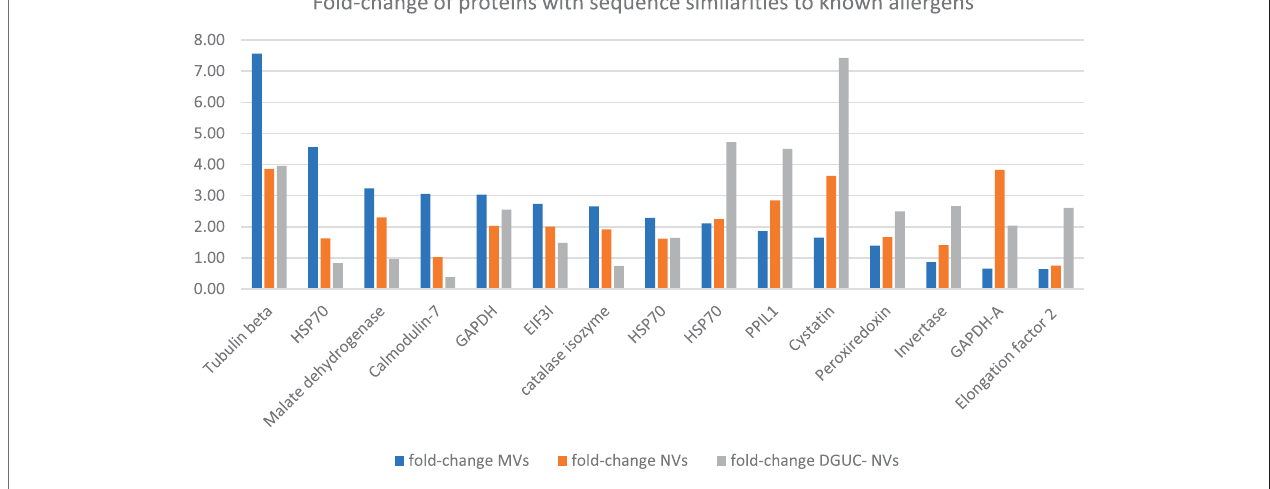
FIGURE 5 | Fold-change of proteins with sequence similarities to known allergens in the COMPARE database and highly expressed in MVs, NVs, or sucrose gradientultracentrifugationseparatedNVsfraction.Fold-changewithrespecttothetotalproteinextractmeasuredbyquantitativeshotgunproteomics( Supplementary Table S5 ).